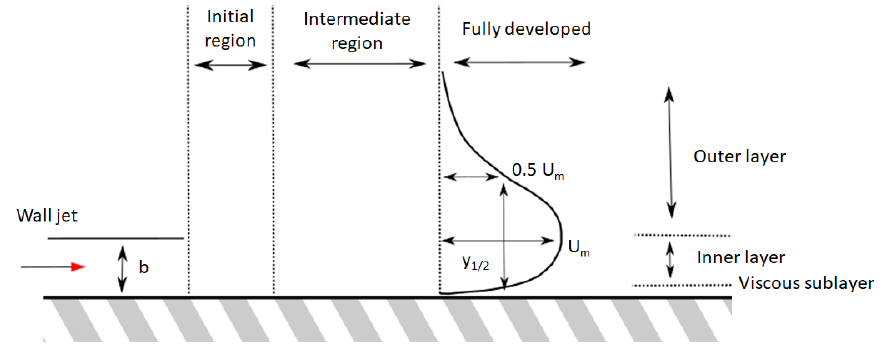
Figure 5. Wall jet schematic representation and nomenclature.